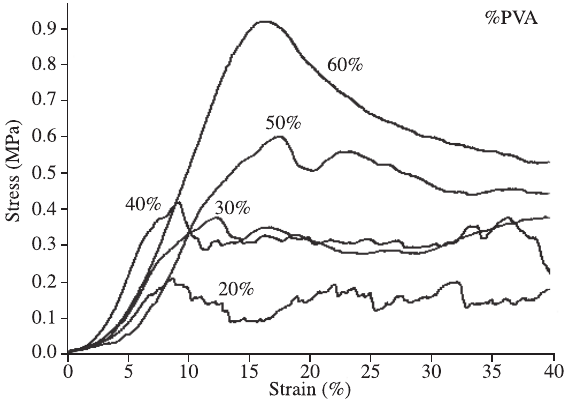
Figure 7. Compression stress-strain curves of hybrid foams with 20 to 60 wt. (%) PVA after